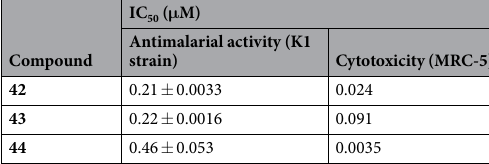
Table 2. In vitro antimalarial activity and cytotoxicity of